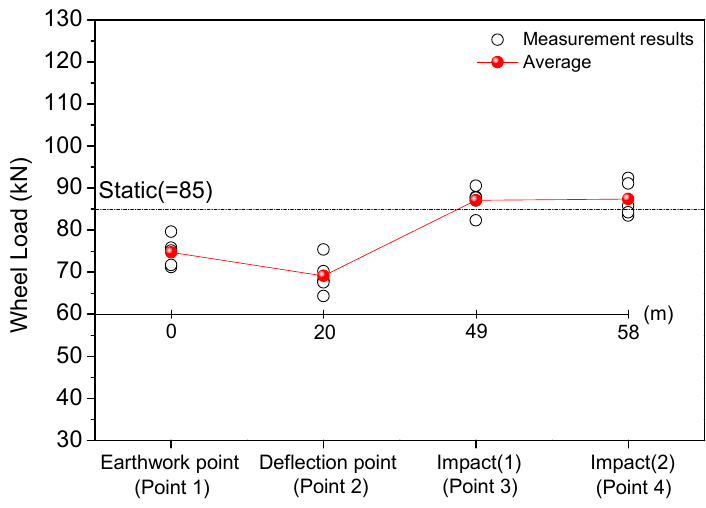
Figure 11. Results of measurement.